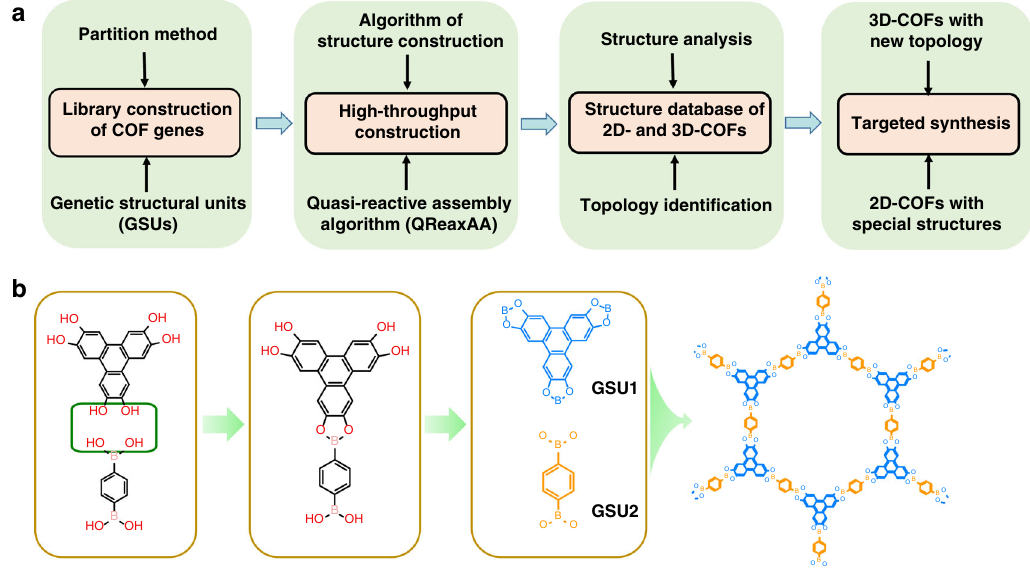
Fig. 1 General idea and partition method for COF genes. a Schematic illustration of the proposed materials genomics strategy. b A concept of genetic structural units with reactive sites was proposed for COF gene partition by mimicking the chemical synthesis processes of COFs, where a dehydration reaction of boronic acid and diol is taken as an example for